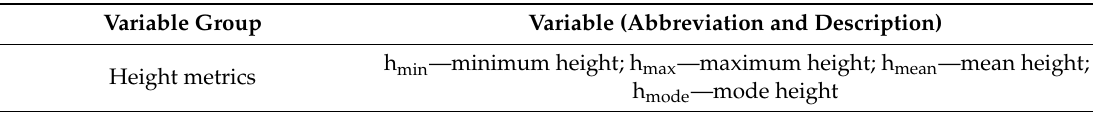
Table 4. Metrics extracted from UAS point clouds (PCs), calculated for each plot and used as potential independent variables in statistical analysis (generation and validation of Lorey’s mean height